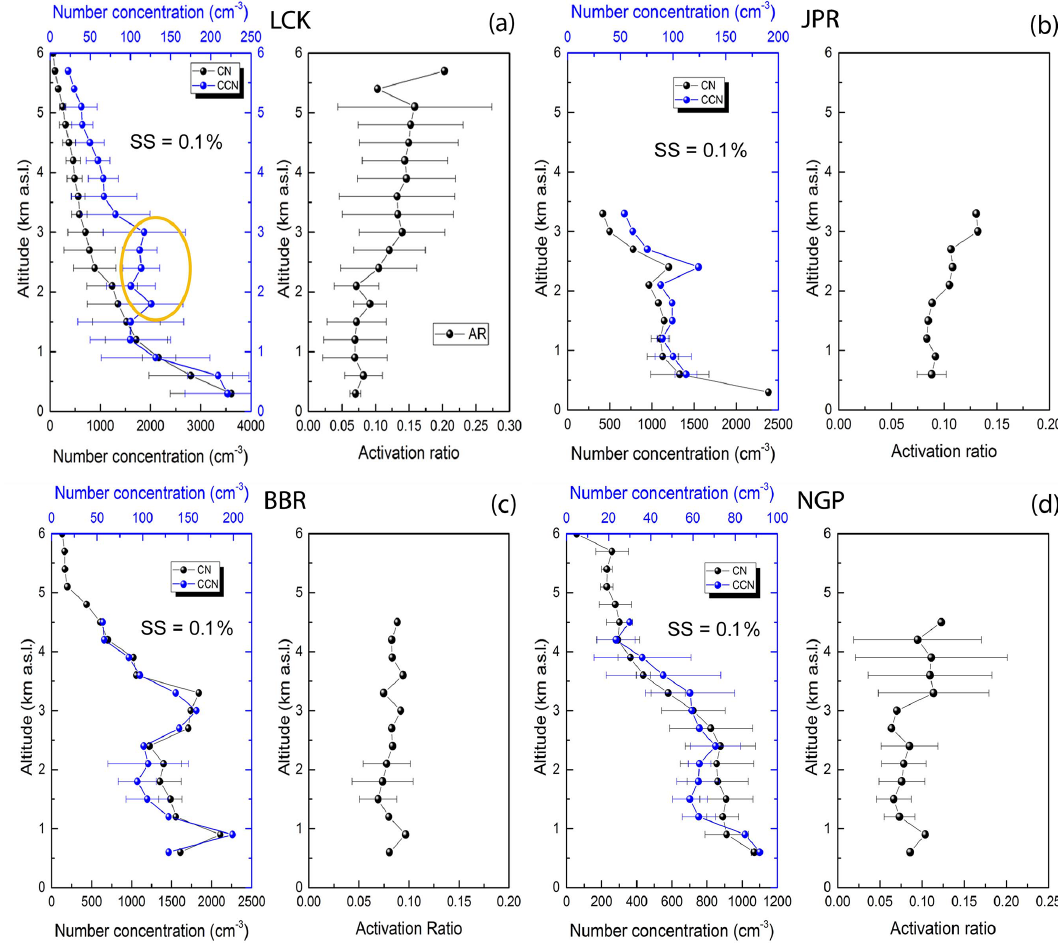
Figure 3. The number concentrations of the CN, CCN at 0.1% supersaturation and AR over LCK, JPR, BBR and NGP are shown in (a) , (b) , (c) and (d) respectively. The activation ratio gives the fraction of the total aerosols which can be converted to CCN at 0.1% supersaturation.